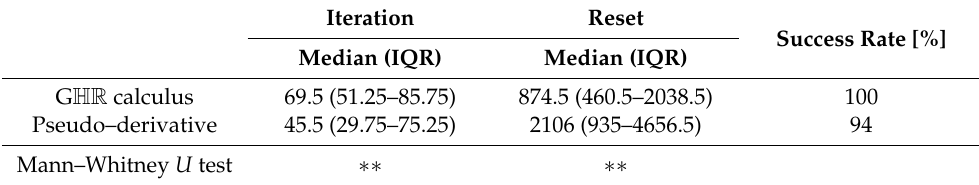
Table 4. Comparison of learning characteristics between the connection weight’s learning